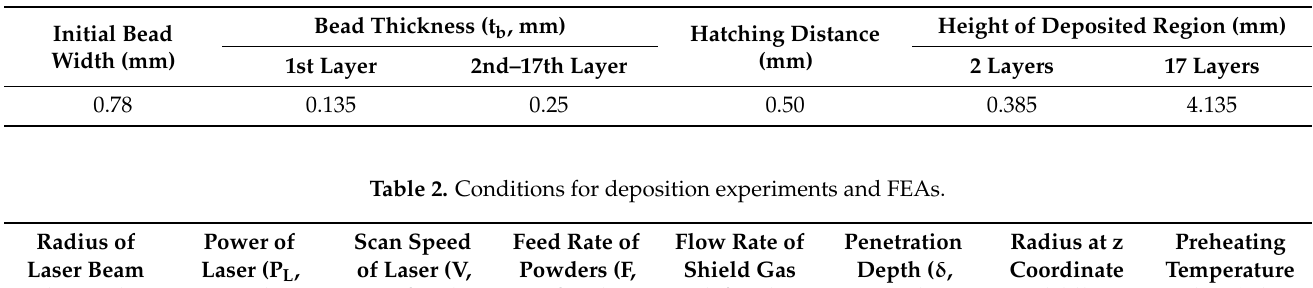
Table 1. Characteristic dimensions of FE models.